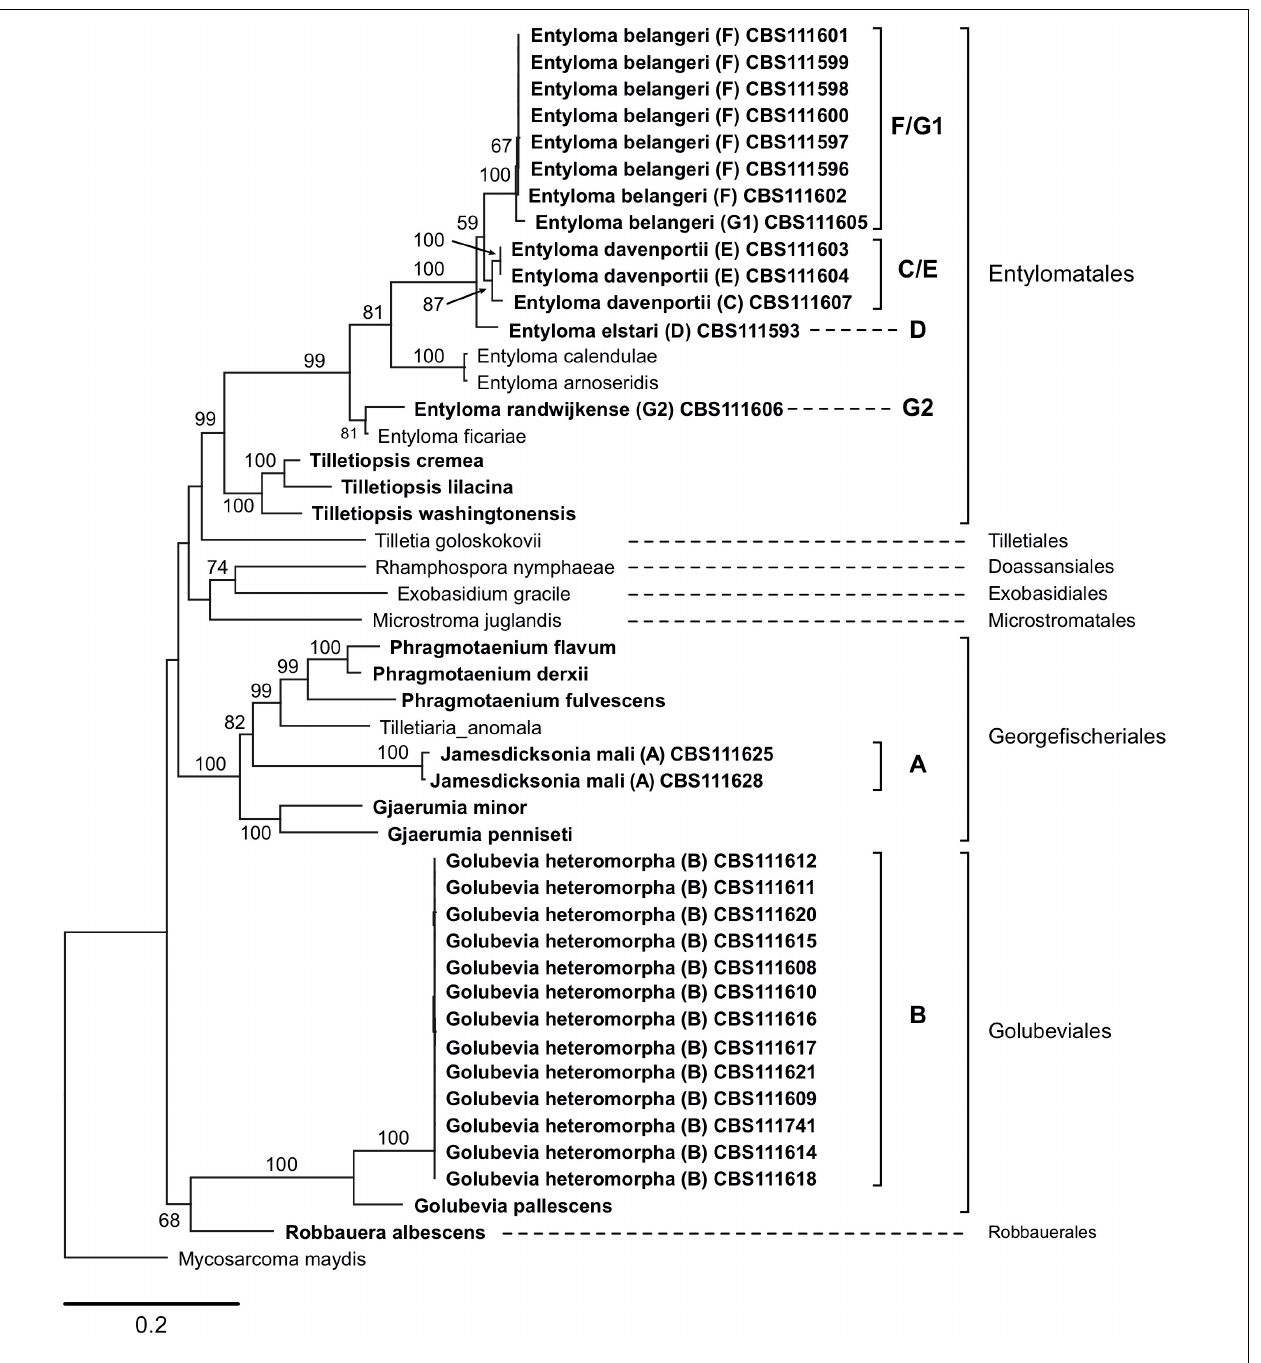
FIGURE 1 | Maximum likelihood analysis of a five-loci alignment combining sequences of the ITS region (including 5.8S rRNA gene), LSU (D1/D2 domains), and SSU rRNA gene, RPB2 , and TEF1 , showing the relationships of taxa within the Exobasidiomycetes. The numbers on branches are frequencies ( > 50%) with which a given branch appeared in 1000 bootstrap replications. The scale bars indicate the numbers of expected substitutions accumulated per site. Nucleotide sequences of Tilletiopsis -like fungi are in bold; clade classification (A–G) follows (Boekhout et al.,